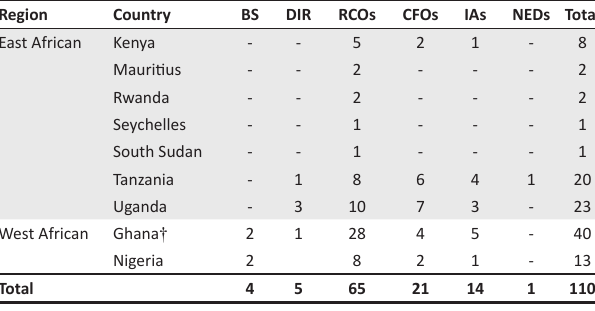
TABLE 1: Number of participants from east and west Africa.